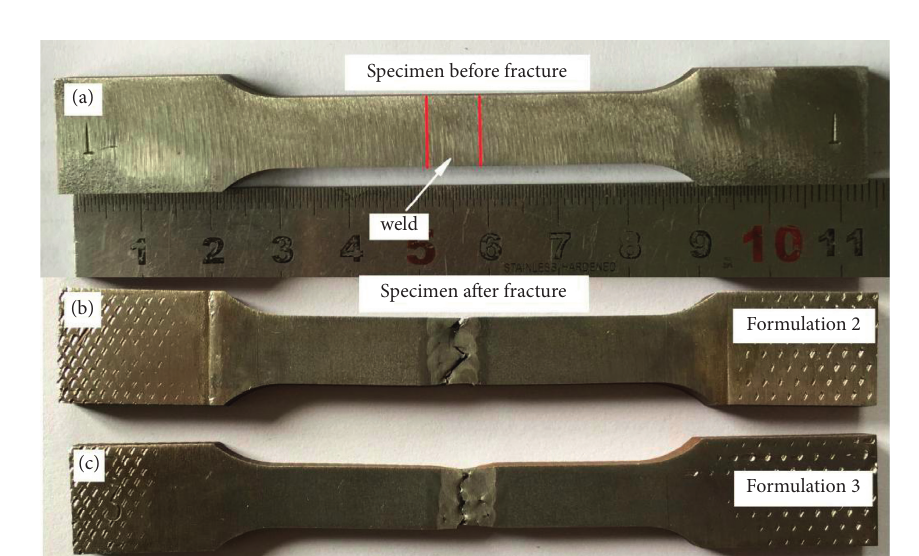
Figure 7: (a) Tensile test specimens before fracture, (b) the flux formulation 2 tensile test specimens after fractures, and (c) the flux formulation 3 tensile test specimens after